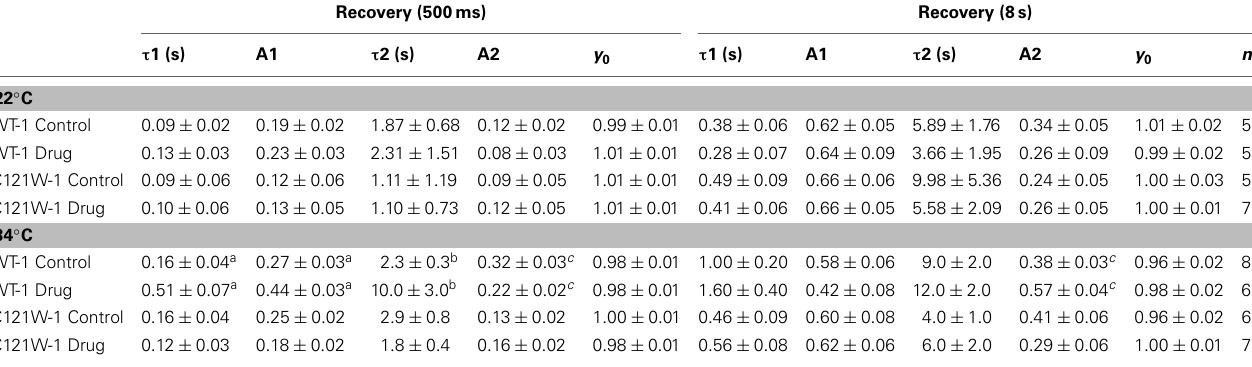
FIGURE 6 | Slow inactivation recovery. Normalized Current is plotted over Control (black) is compared to 100 μ M Lacosamide (red). For both WT at the various recovery durations (s). Recovery was measured using both 22 ◦ C and 34 ◦ C (A,B) and C121W at 22 ◦ C and 34 ◦ C (C,D) . Panel (D) shows a pulse protocol inset used to measure slow inactivation recovery. 500ms prepulse durations (closed circles) and also 8s (closed squares). Table 7 | Slow Inactivation Recovery. Recovery (500ms) Recovery